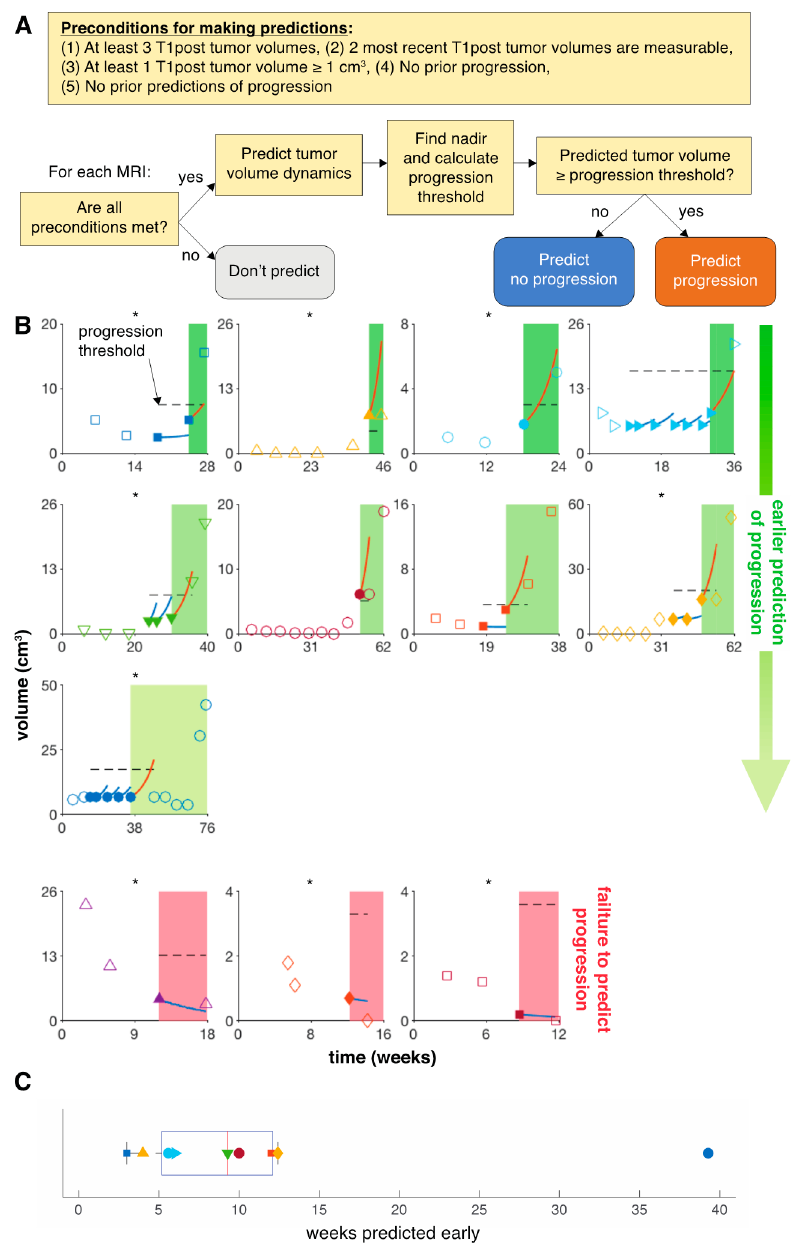
Figure 3. Model predicts progression for 9 of 14 patients with recurrent HGG in a LOOCV. ( A ) Decision diagram for making predictions. ( B ) Using the 200% increase in T1post tumor volume from nadir progression criterion, which maximizes NPV, we follow the decision diagram for each MRI. No predictions were made for 2 patients (not shown) due to no T1post tumor volume ≥ 1 cm 3 . Of the 9 patients predicted to progress, four were predicted to progress one scan early, four were predicted to progress two scans early, and one was predicted to progress six scans early. Filled markers identify the radiological data from which the model forecast has been performed. Blue and red curves show the model prediction relative to the progression threshold (dashed line). Asterisks mark patients who progressed due to T2/FLAIR non-enhancing lesions or clinical deterioration. All three patients whose progression failed to be predicted progressed despite accurately predicted diminished T1post